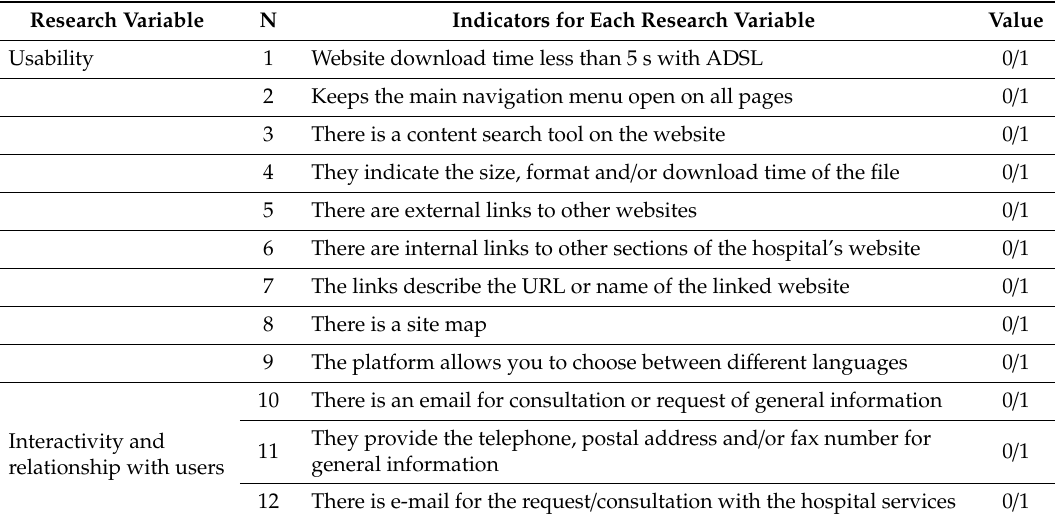
Table 2. Research variables of study and indicators stablished for each